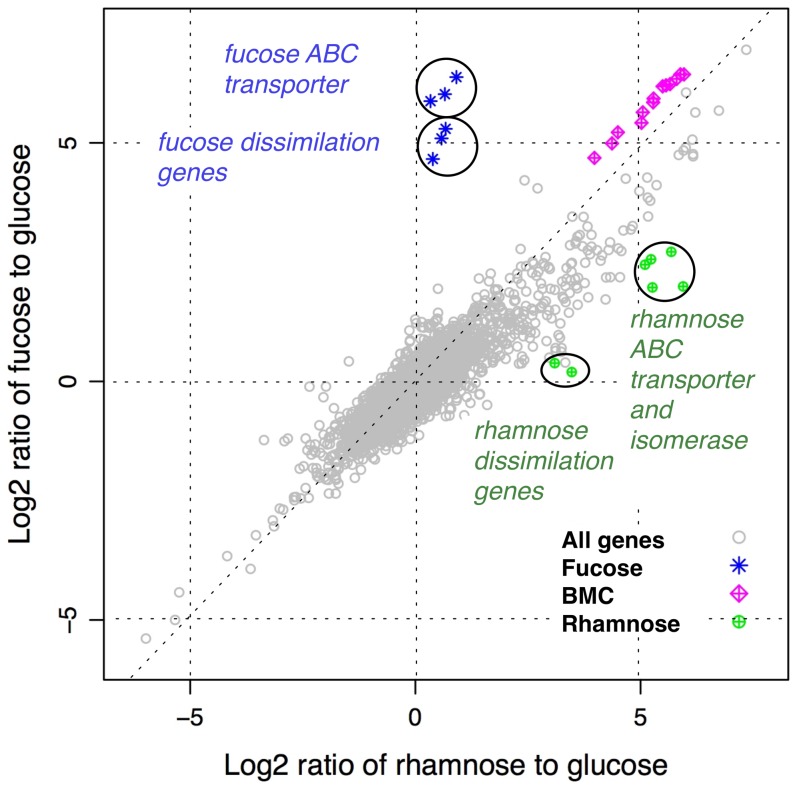
Scatterplot of gene expression on fucose and rhamnose relative to glucose.Expression values were calculated from the average of two rhamnose or fucose measurements divided by the average of two glucose measurements.